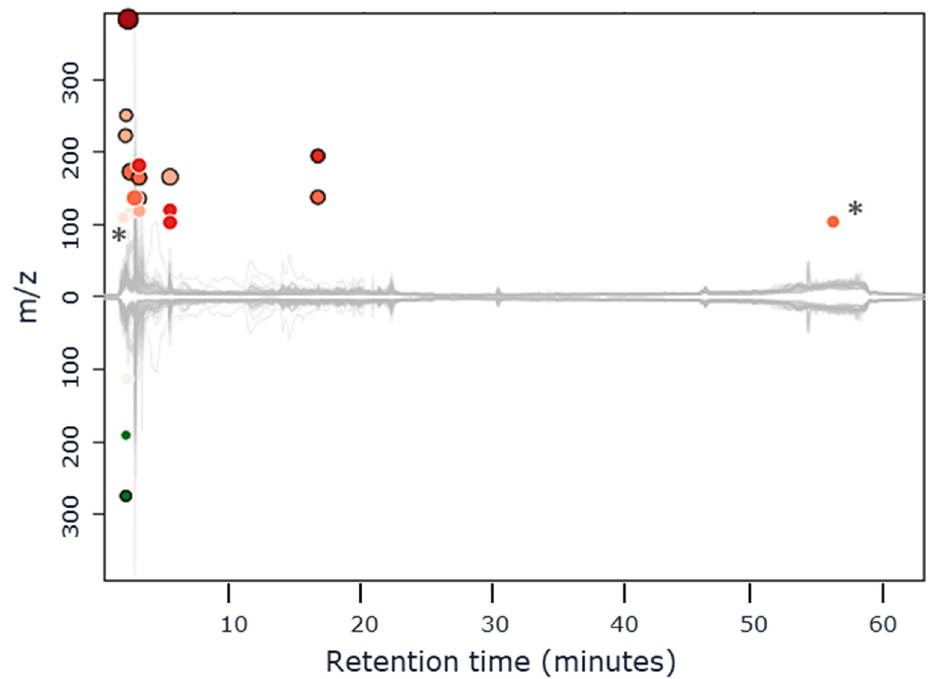
Figure 1. Cloud plots showing under- and over-expressed features with age in RPLC/MS+. The red bubbles over the chromatogram represent the over-expressed features and the green bubbles under the under-expressed. The bigger the bubble is, the bigger the fold change, and the darker the bubble, the more significative the p -value. * corresponds to features that were removed after manual verifi- cation.